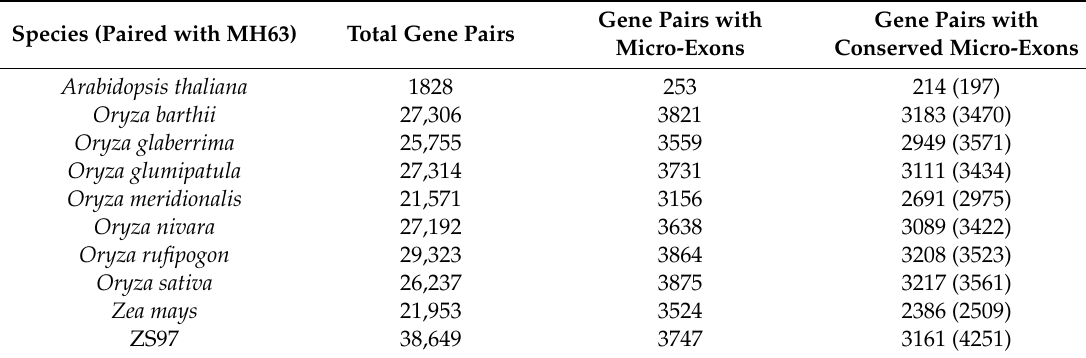
Table 1. Conservation of genes containing